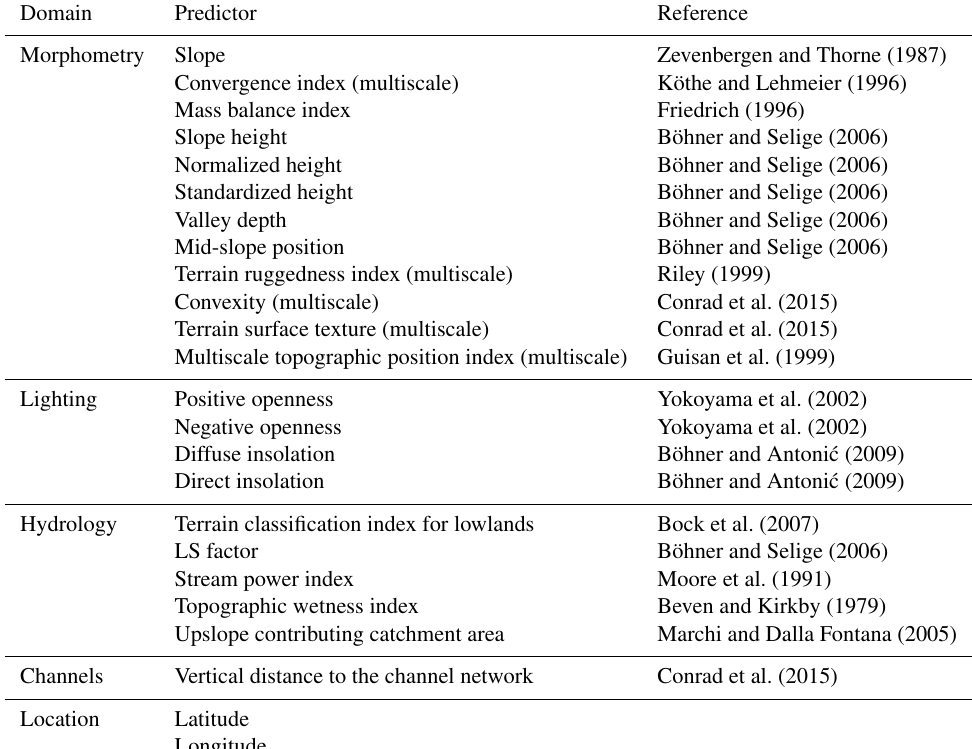
Table 1. Topographic predictors derived from the digital elevation model. Indices that have been calculated with varying window sizes are denoted by